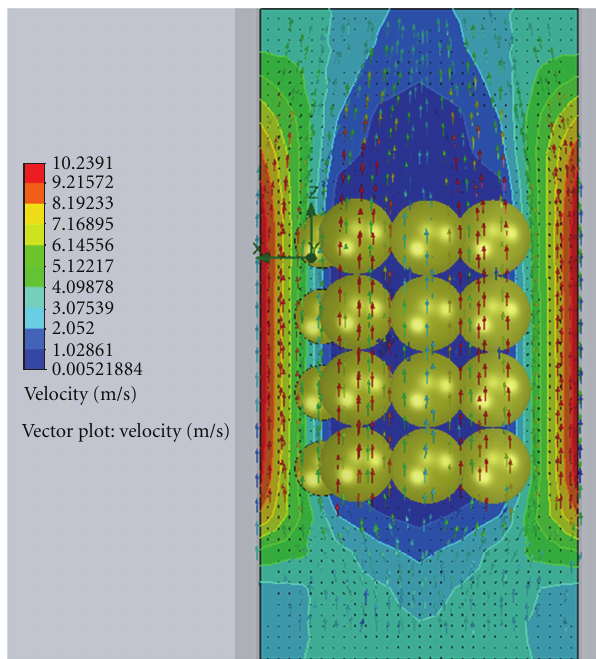
Figure 12: Velocity vectors plot of the water vapour velocity field in a packed bed the inlet.